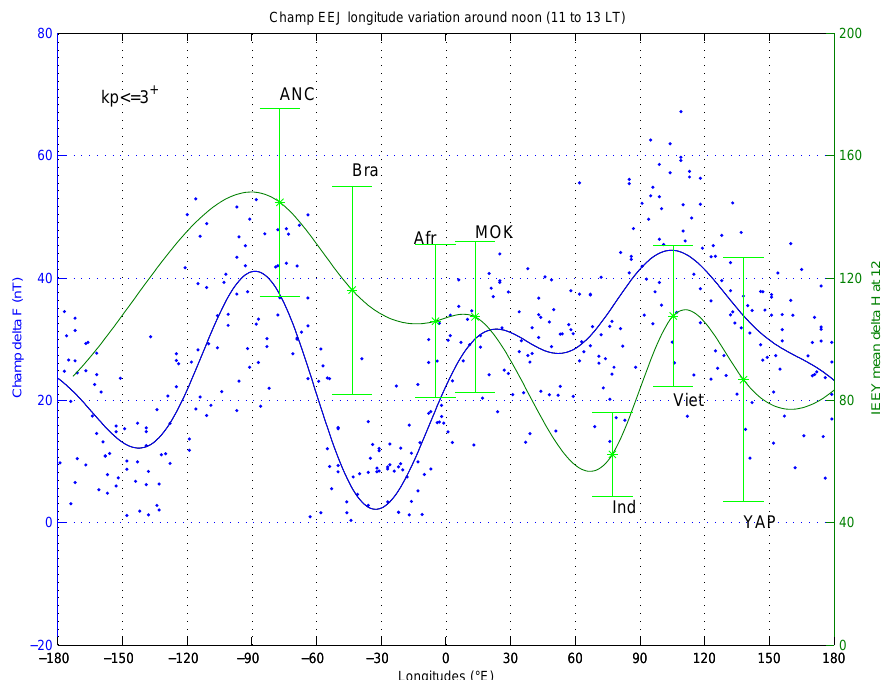
Fig. 3. The longitudinal variation of CHAMP satellite borne EEJ magnetic signature around noon (from 11:00 to 13:00 LT). The dotted plot represents the individual 1F versus the longitude of each satellite pass, whereas the blue line curves depict average behavior. The green line with error bars represents the ground-based mean longitudinal variation of the EEJ magnetic effects at 12 H , including data from Baclieu